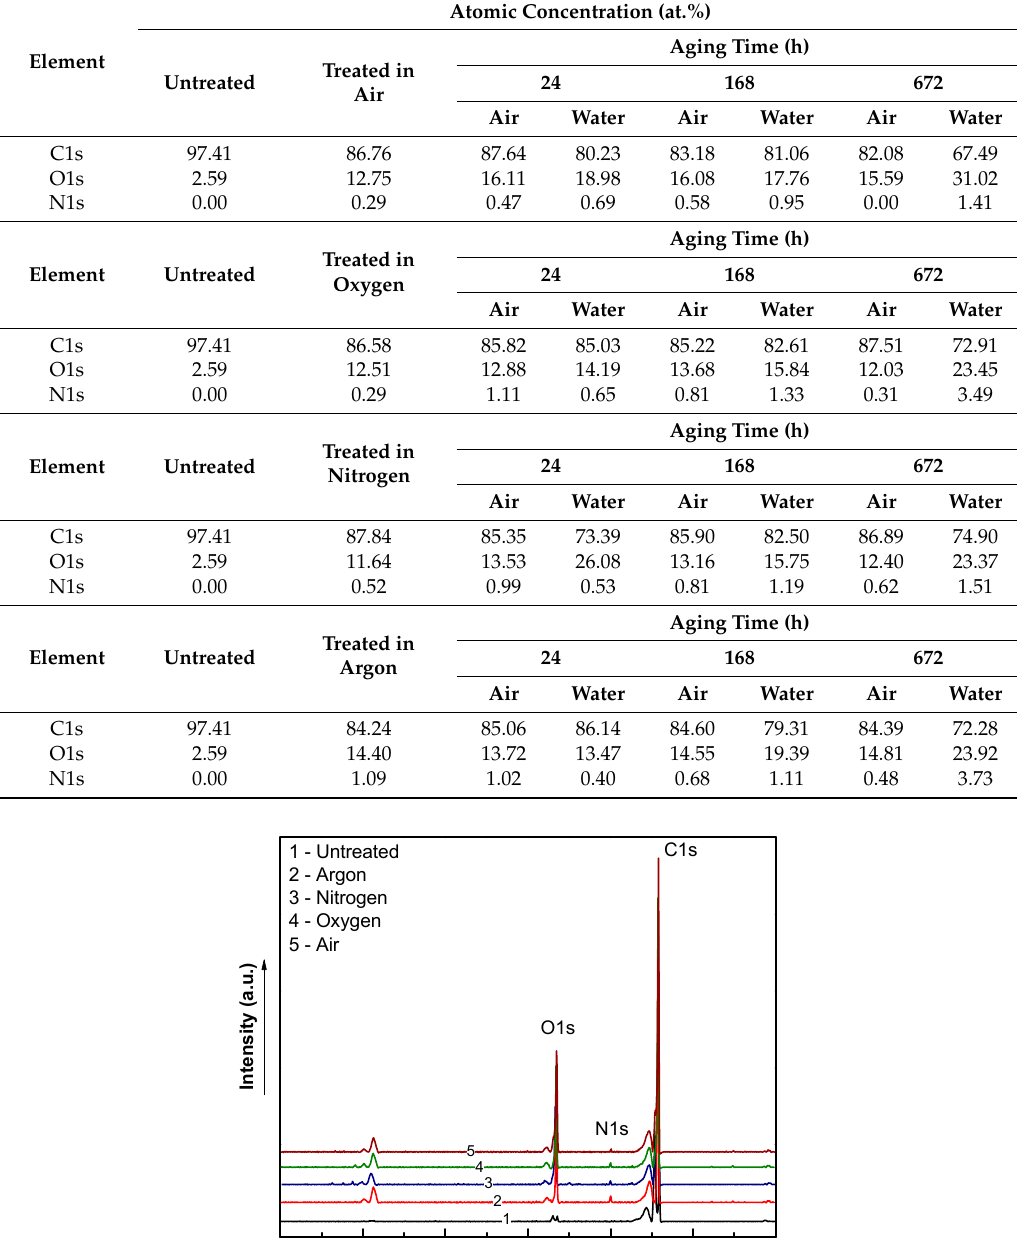
Table 1. Chemical composition of LDPE treated using different gases and aged in air or water. Atomic Concentration (at.%) Element